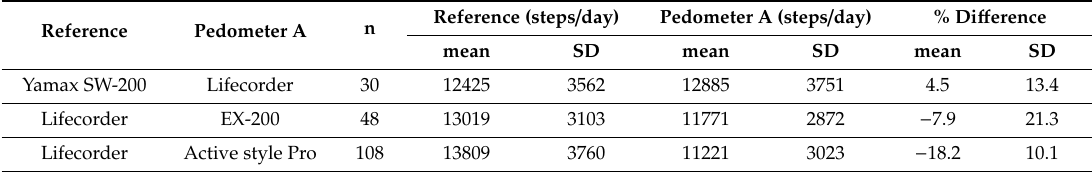
Table 1. Comparison of daily step counts between pairs of